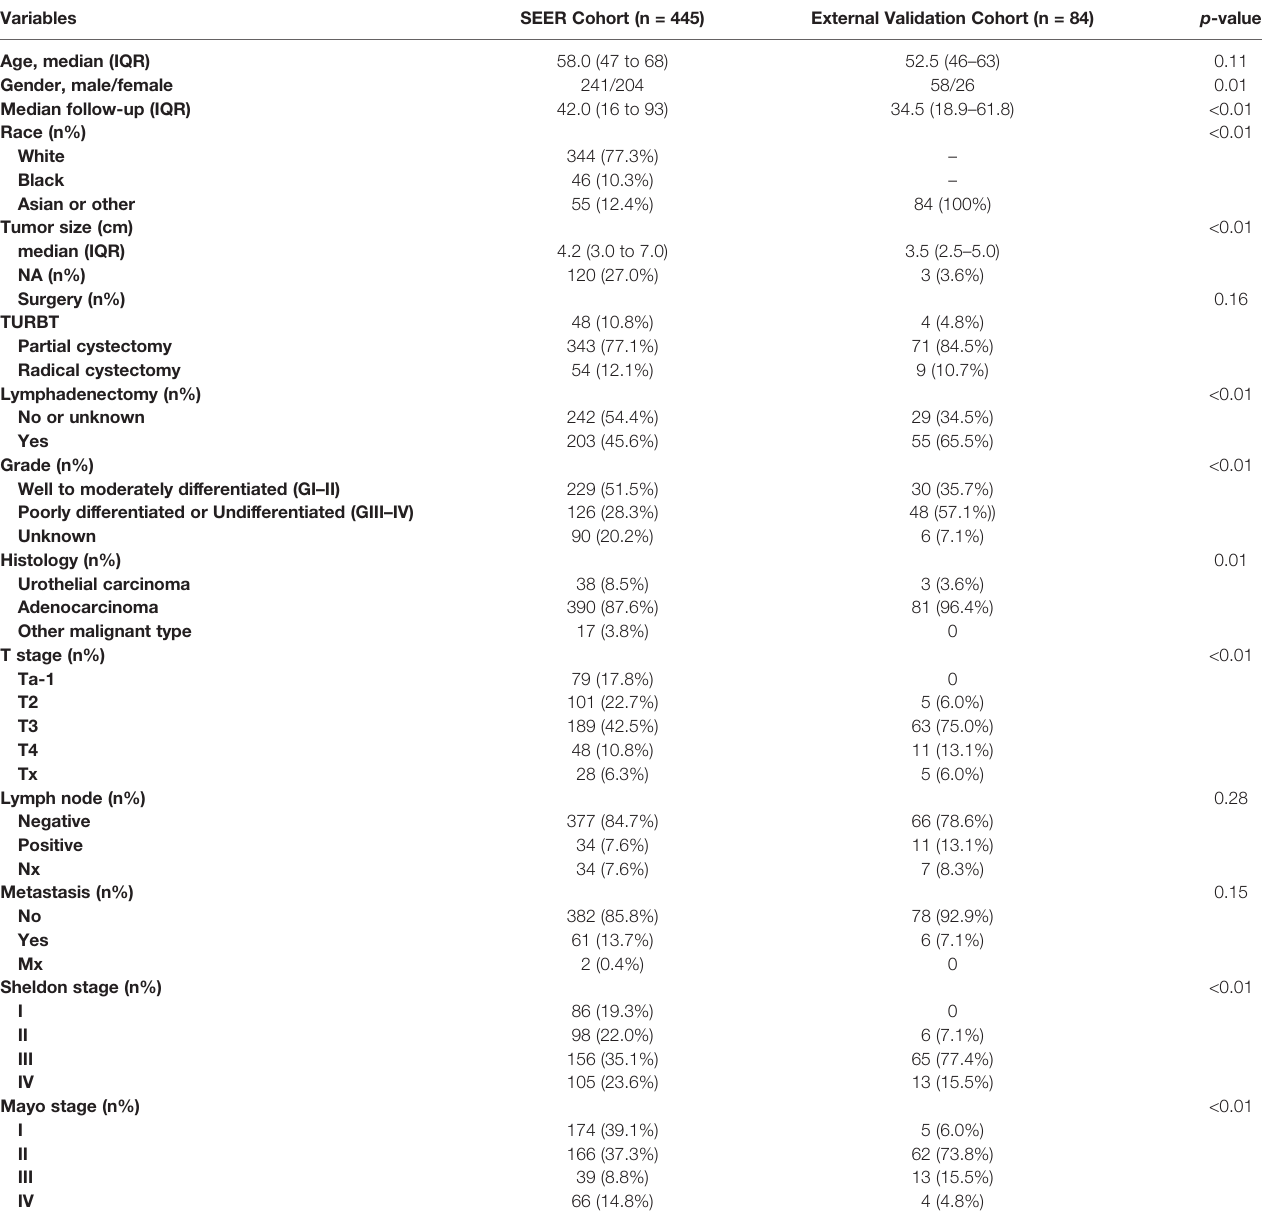
TABLE 1 | Patient characteristics of training and validation